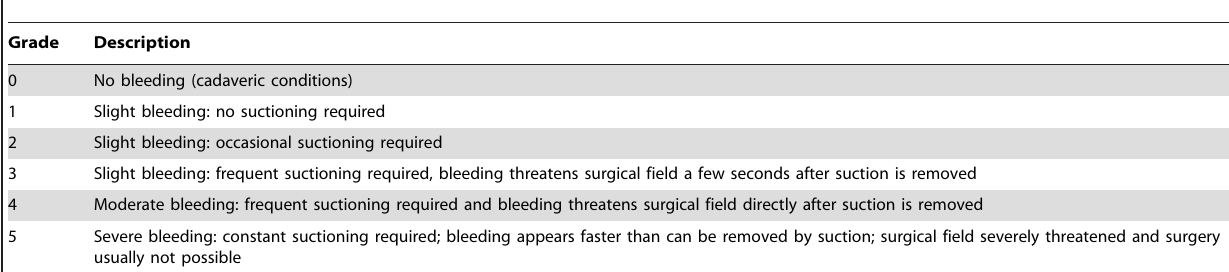
Table 1. Boezaart grading for categorizing the quality of surgical field.